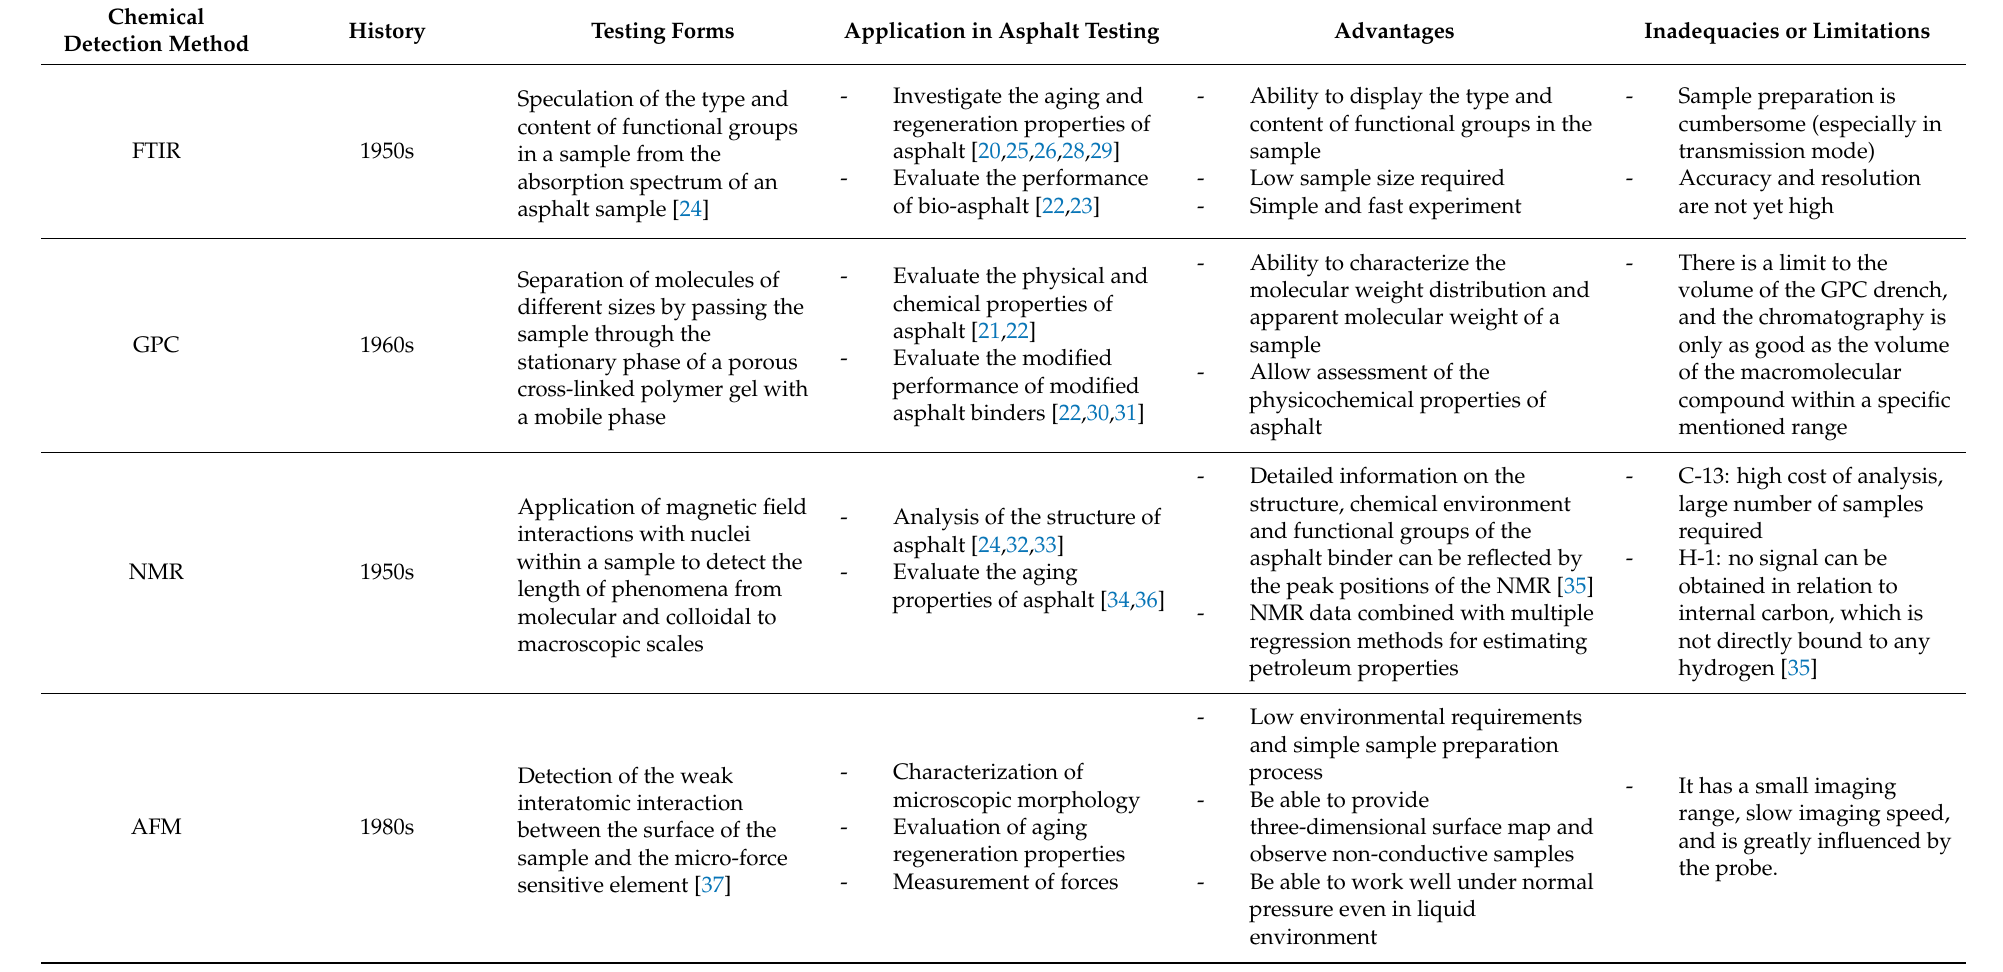
Table 1. A summary of the advantages and disadvantages of FTIR, GPC, and